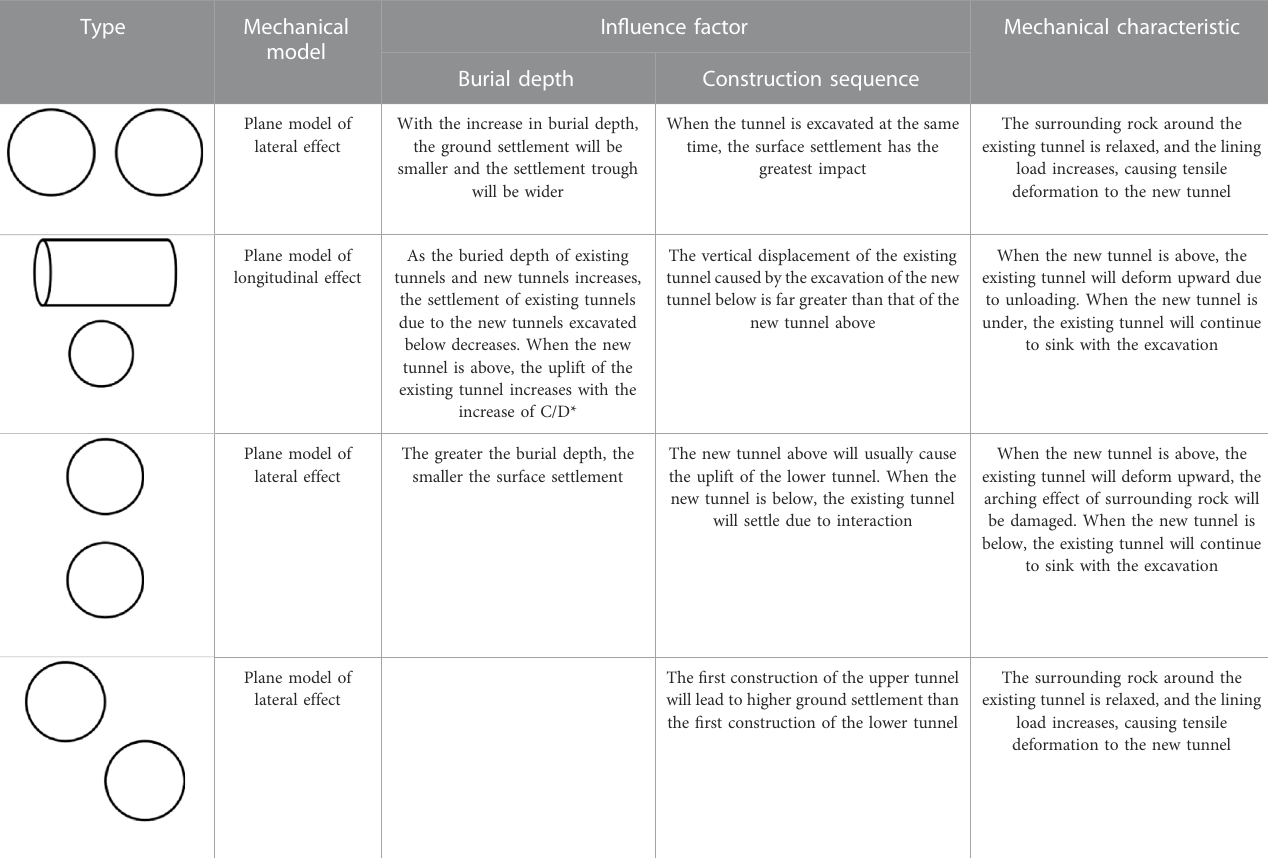
TABLE 1 Types and in fl uence factors of adjacent